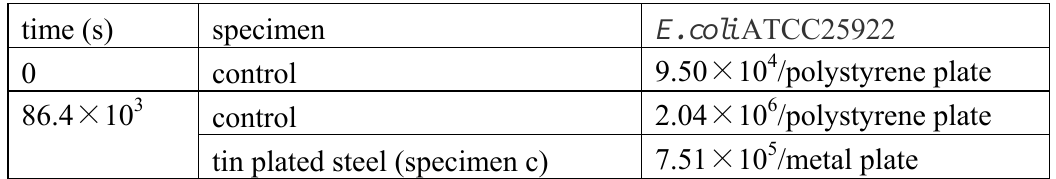
Table 1. Antibacterial effects for tin plated steel measured by Film Covering